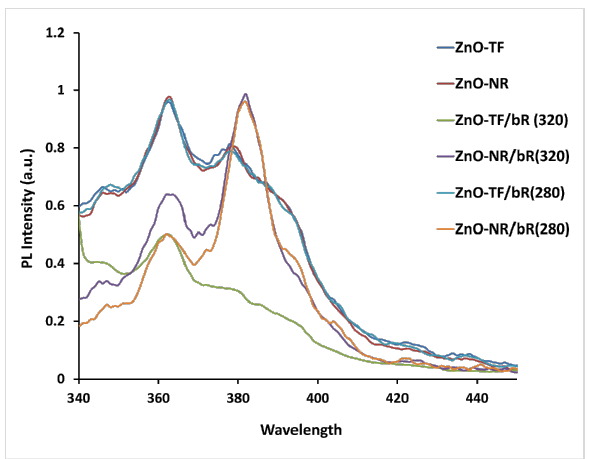
Figure 4: Photoluminescence spectral analysis for the ITO/ZnO-TF and ITO/ZnO-NR structures, and the respective hybrid structure for the structural analysis of the